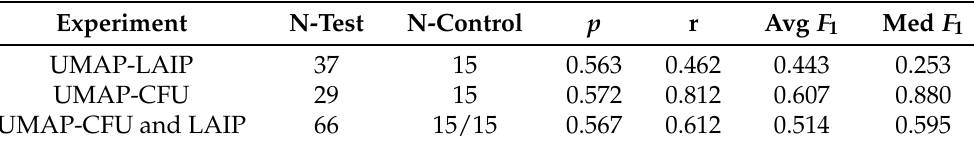
Table 2. Results of the proposed classification pipeline. For CFU and LAIP tubes separately and